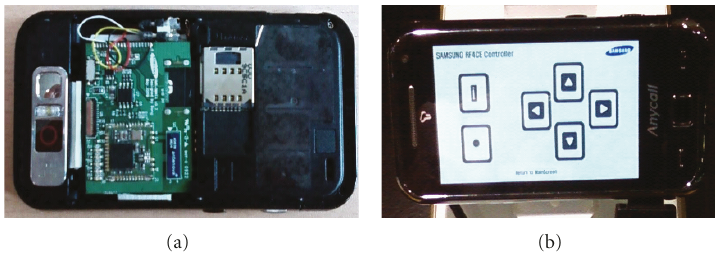
Figure 9: Mobile Phone (Omnia) and its embedded prototype module.